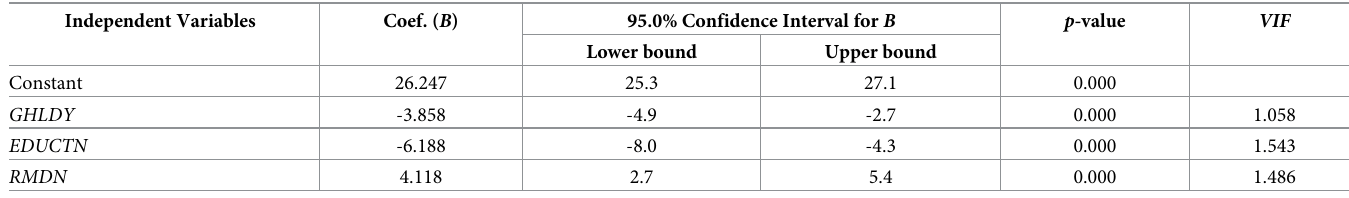
Table 3. Results of the developed multivariate multiple linear regression model. Independent Variables